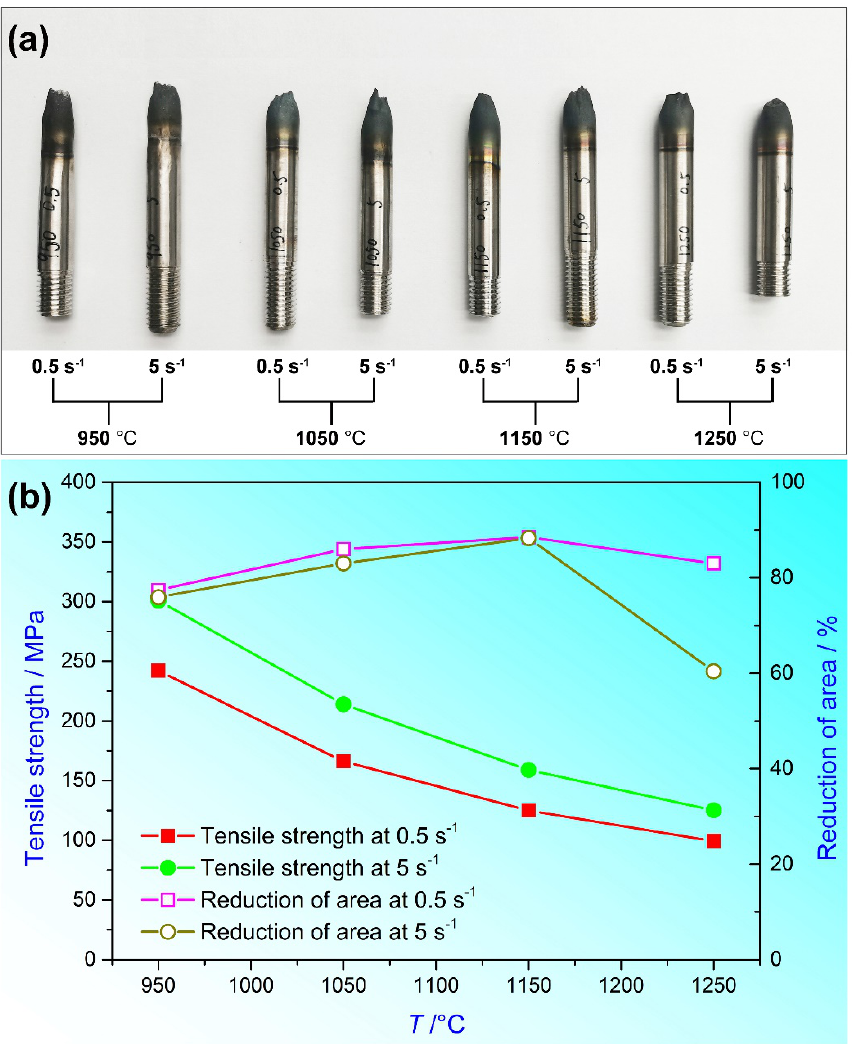
Figure 9. The state of the failed hot tensile specimens ( a ) and the evolution of tensile properties with different tensile parameters ( b ).